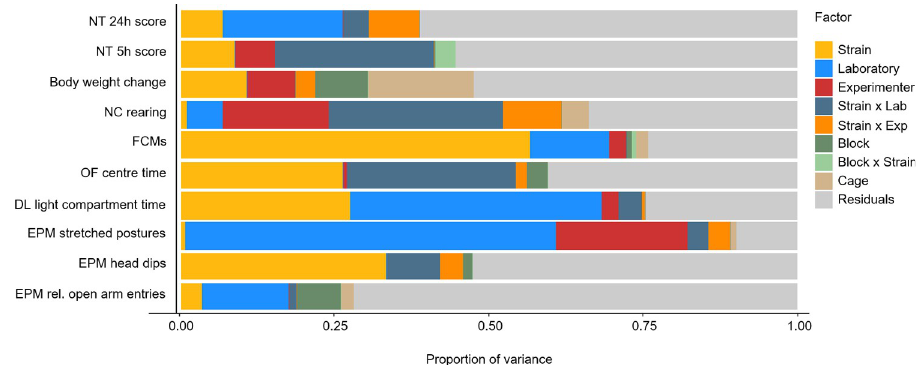
Fig 4. Proportion of variance explained by each factor. For each outcome measure, the total variance of the full dataset could be decomposed into the following sources using an LMM: between-strain variability (yellow), between- laboratory variability (blue), between-experimenter variability (red), strain-by-laboratory interaction variability (dark blue), strain-by-experimenter interaction variability (orange), between-block variability (dark green), strain-by-block interaction variability (light green), between-cage variability (beige), and between-individual variability (residuals, grey). Shown are point estimates of the proportion of variation explained by each factor. For details on 95% confidence intervals of these estimates, see S7 Table. The raw data underlying this figure are available in the Figshare repository https://figshare.com/s/f327175aa8b541ef01bd. DL, Dark Light; EPM, Elevated Plus Maze; FCMs, faecal corticosterone metabolites; LMM, linear mixed model; NC, Novel Cage; NT, Nest; OF, Open